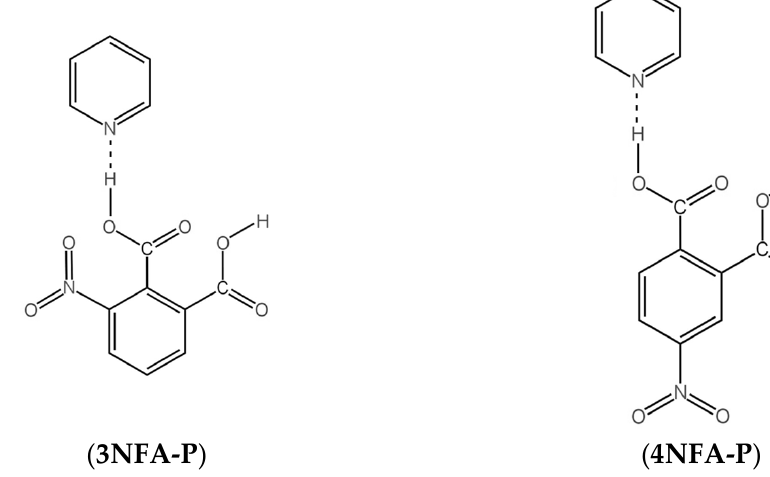
Figure 1. Chemical structures of 3-nitrophthalic ( 3NFA-P ) and 4-nitrophthalic ( 4NFA-P ) acid com- plexes with pyridine.